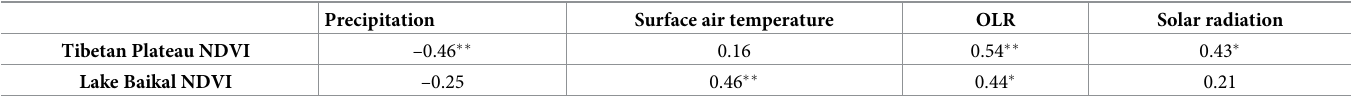
Table 1. Correlation coefficients between the Tibetan Plateau–Lake Baikal NDVI index and local climate factors (precipitation, surface air temperature, OLR and solar radiation) on an interannual